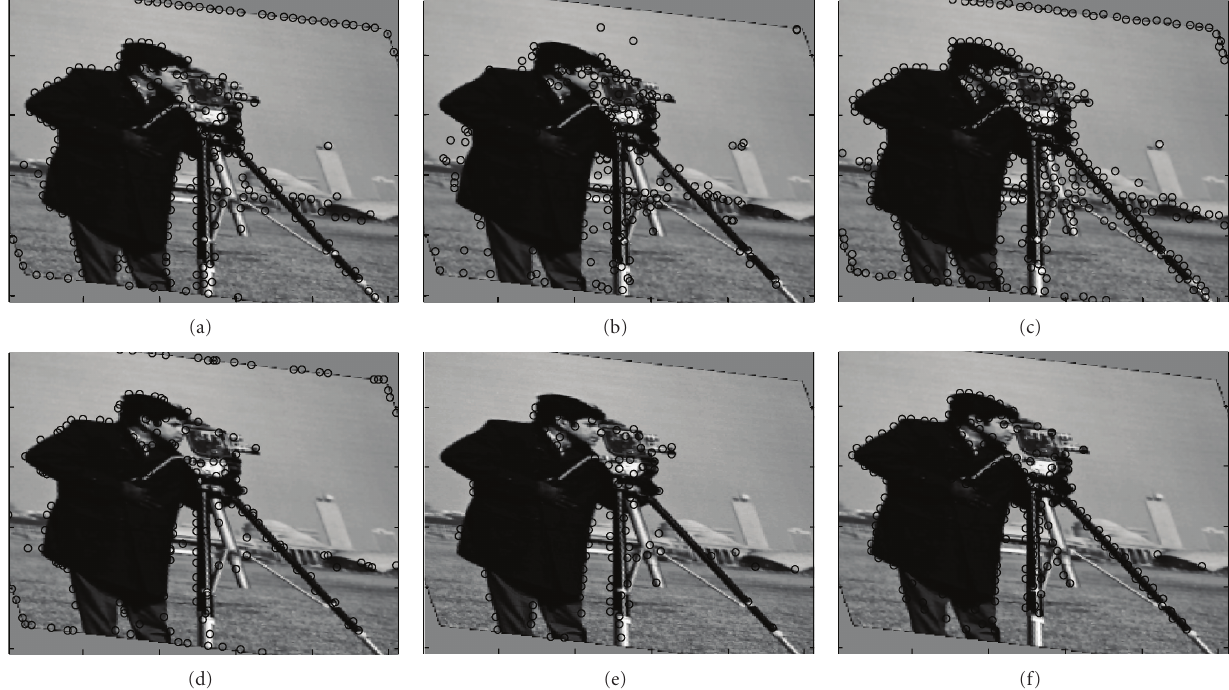
Figure 9: Feature points detected in sheared image by (a) Harris’ method, (b) Lowe’s method, (c) Tomasi’s method, (d) Loupias’ technique, (e) Yeh’s algorithm, and (f) proposed